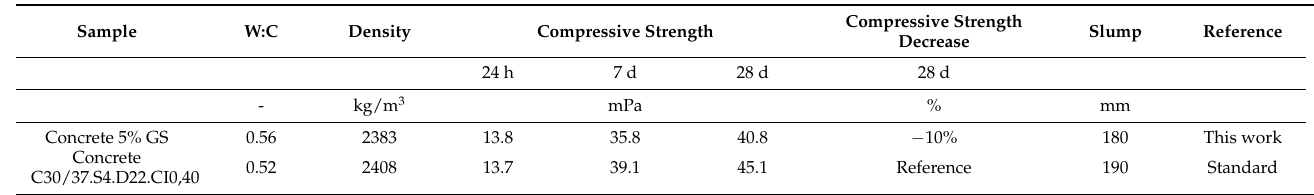
Table 5. Comparison of Water: Cement ratio (W:C), apparent density, compressive strength, compressive strength decrease, and slump of concrete 5% GS with standard structural Concrete C30/37.S4.D22.CI0,40.